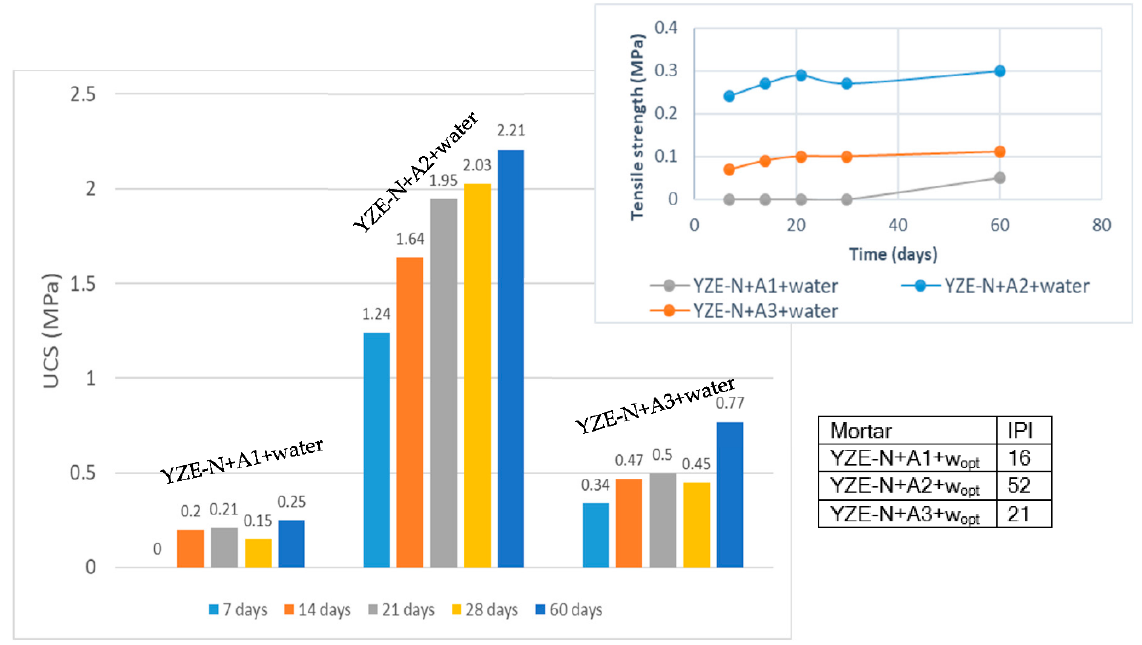
Figure 12. UCS and tensile strength results for Yzernay TC mortar with all three ecobinders.